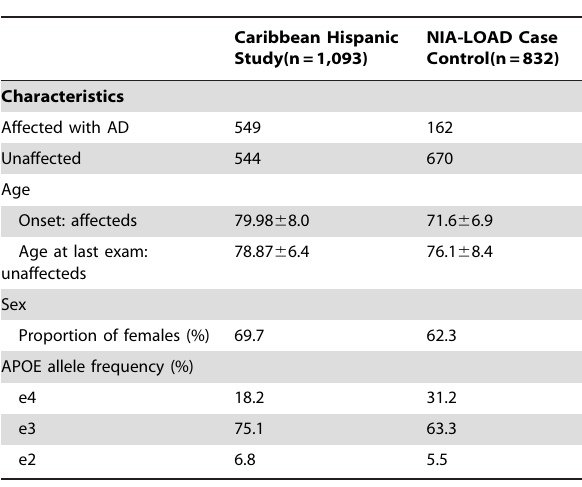
Table 1. Characteristics of the study